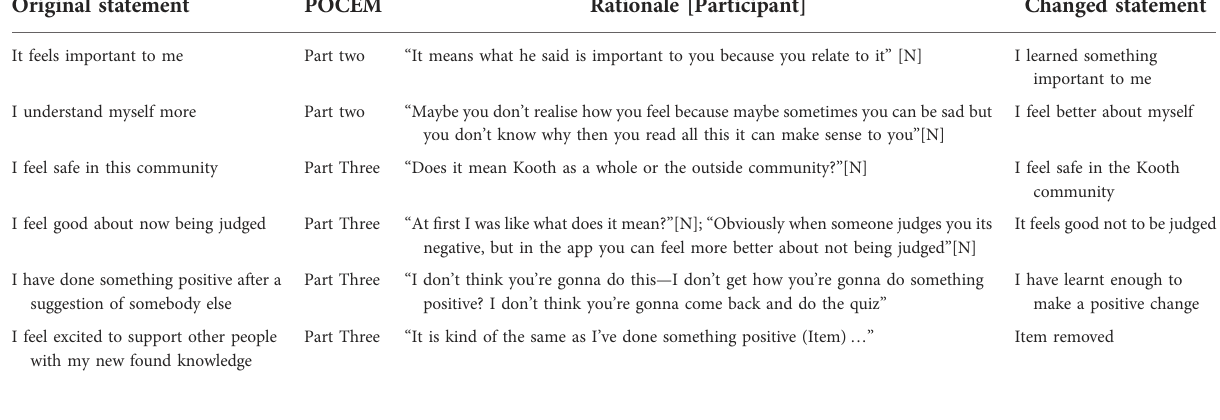
TABLE 5 User testing af fi nity diagram fi ndings and changes in wording of the measure. Original